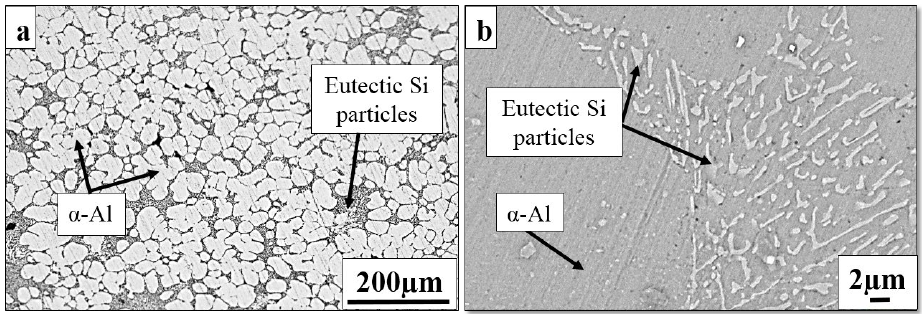
Figure 2. Microstructural features of the cooling slope Al–7Si alloy by ( a ) optical micrograph and ( b ) SEM morphology of eutectic Si. SEM morphology of eutectic